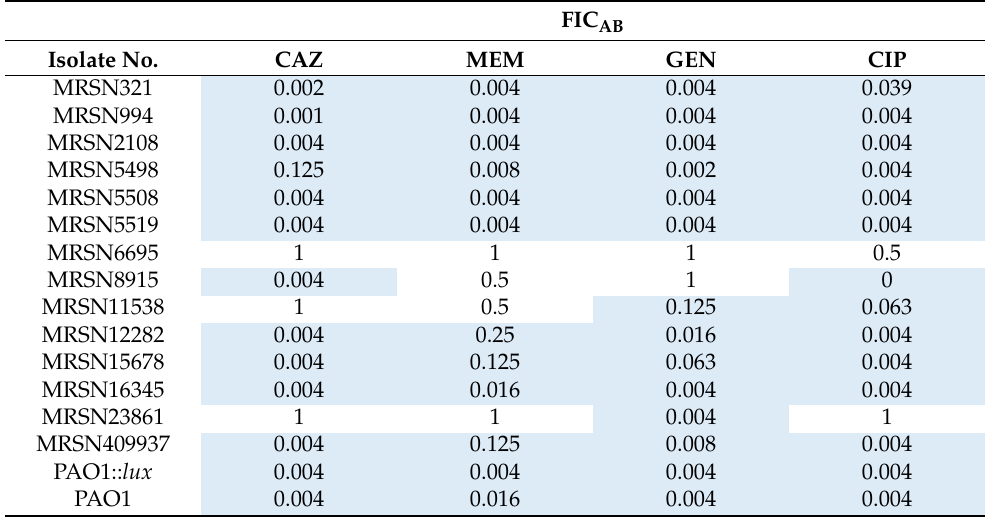
Table 4. FIC AB values for four antibiotics against 16 P. aeruginosa